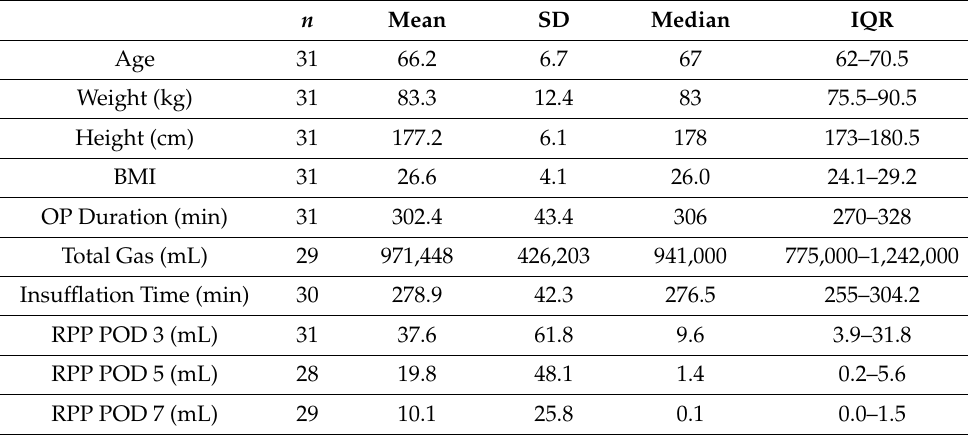
Table 1. Summary of the patient demographics and operative